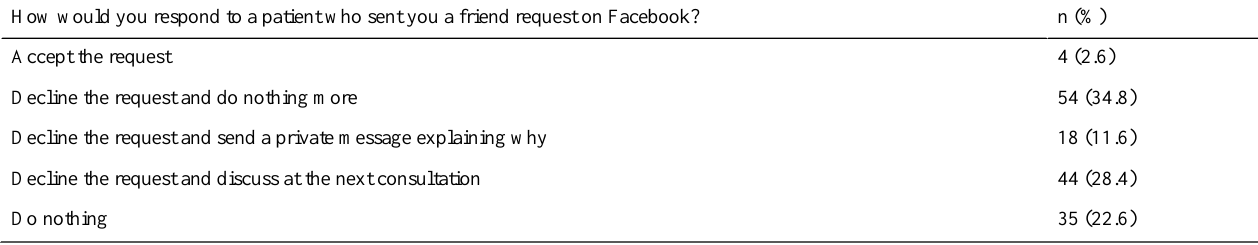
Table 2. Doctors’response to friend request from a patient